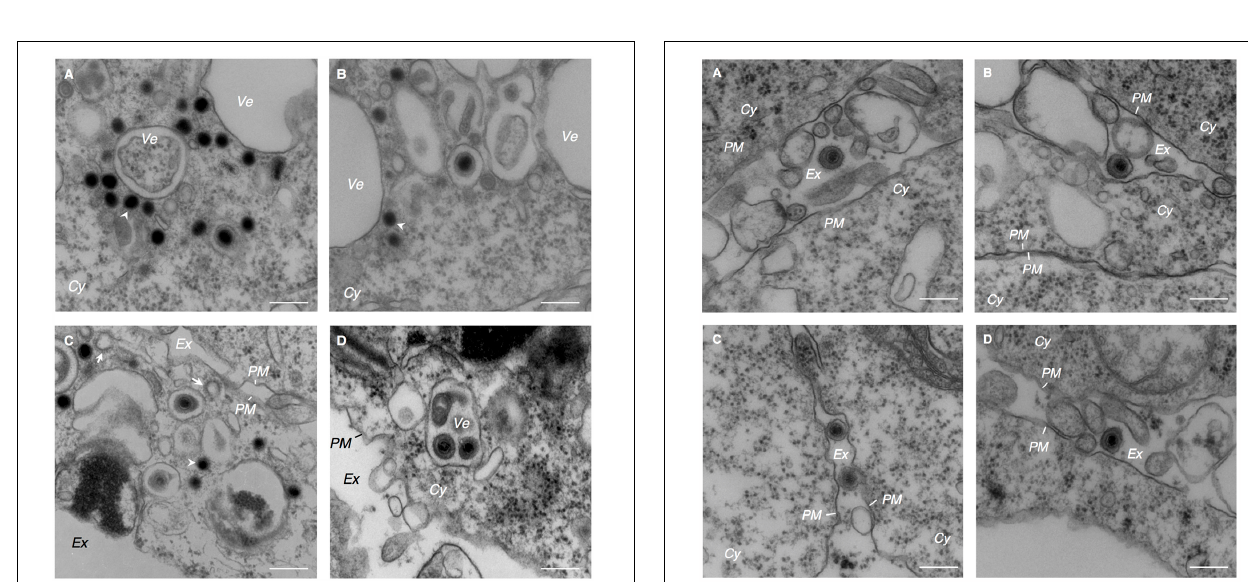
FIGURE 2 | EBV acquires its primary envelope by budding into the perinuclear space. Morphological features of Akata − eGFP-EBV cells induced into the lytic cycle showing primary envelopment and nuclear egress. Akata − eGFP-EBV cells were treated with α hIgG for 24 h. Low (A) and high (B–E) power views of Akata − eGFP-EBV cells. (B) Represents boxed area in (A) . The white arrowhead indicates high electron-dense material. Scale bars: 1 µ m (A) and 250 nm (B–E) .